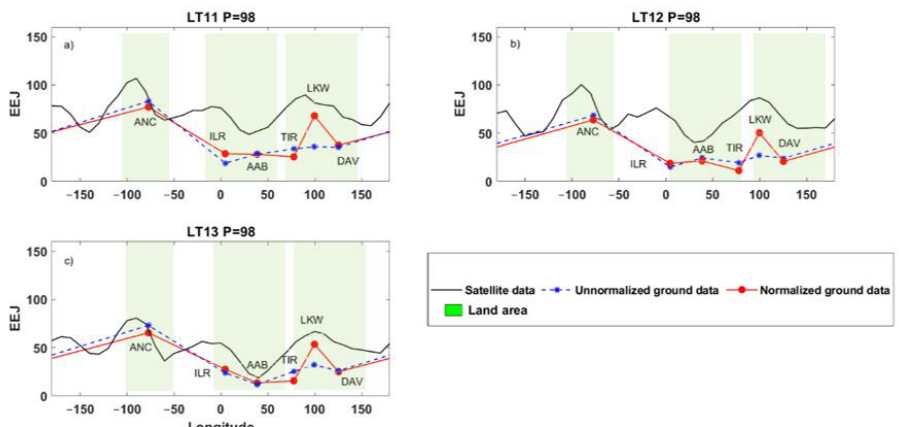
Figure 3. The longitudinal variation of the EEJ current derived from the ground (nT) and satellite (mA/m) data during moderate solar activity level ( P = 98) at ( a ) 11 LT ( b ) 12 LT, and ( c ) 13 LT.